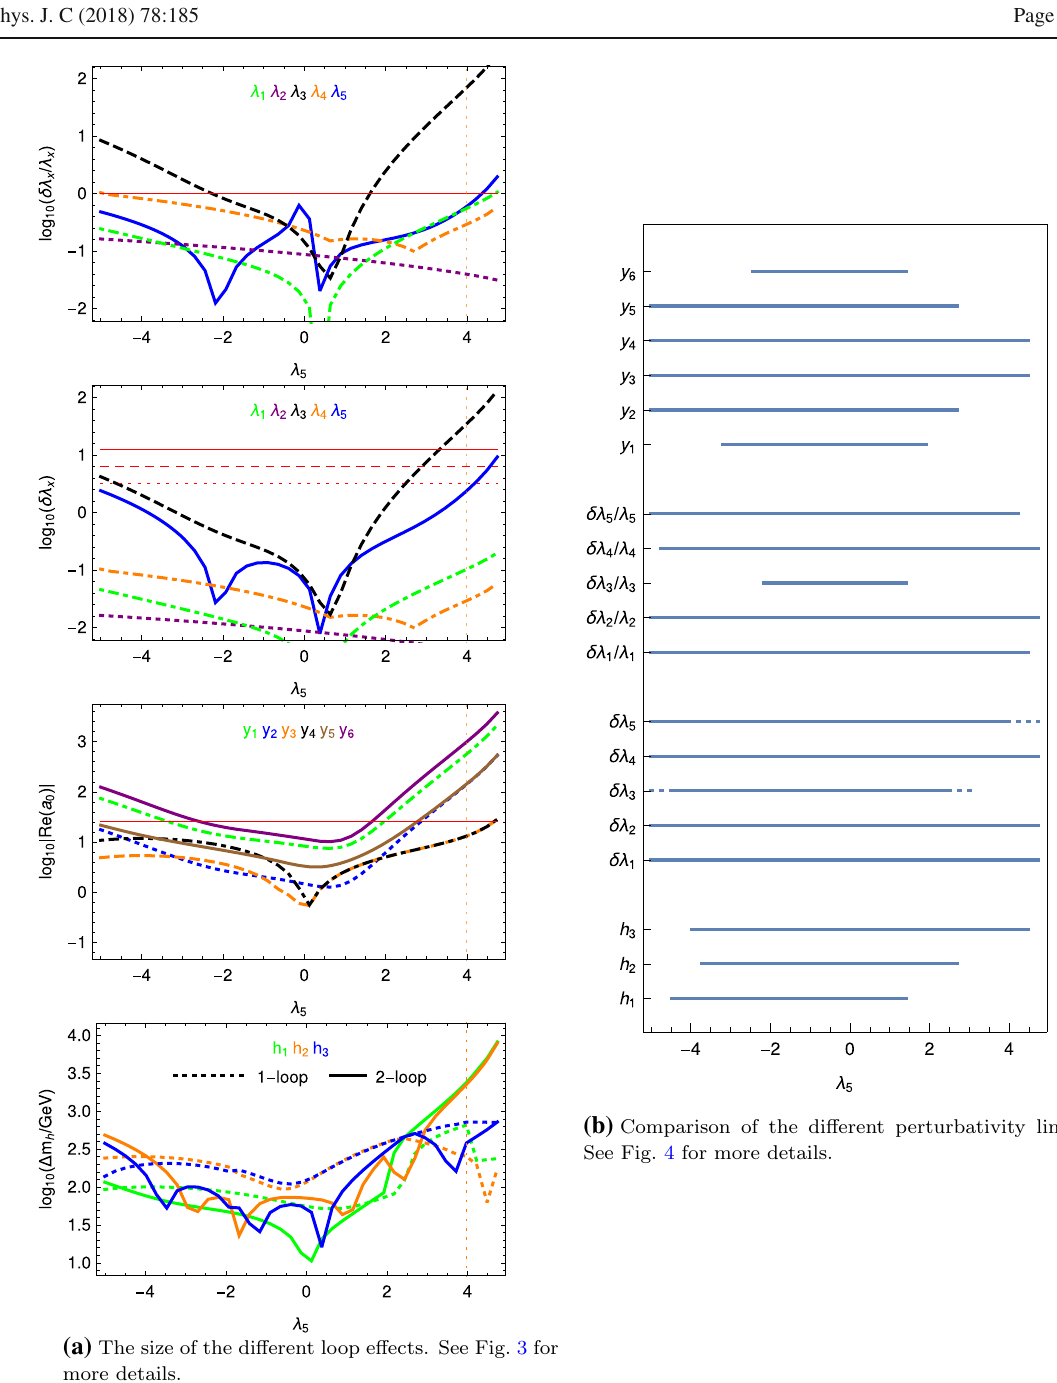
( a ) The size of the different loop effects. See Fig. 3 for more details. Fig. 7 Perturbativity limits as function of λ 5 . The other parameters are chosen as: λ 2 = 0 . 1, λ 3 = 0 . 5, λ 4 = − 0 . 1, α = 20 ◦ , s H = 0 . 3, m H = 750